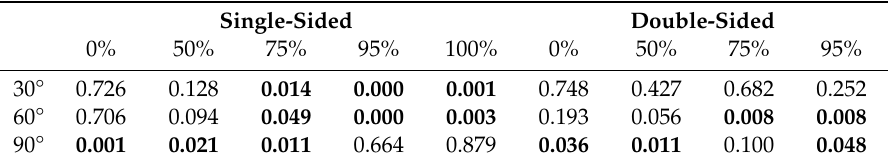
Table A2. p -values for the data presented in Figure 8 (single- and double-sided etched channels with tape on both sides), generated using a two-tailed, unequal variance t-test comparing the 30 ◦ , 60 ◦ , and 90 ◦ conditions to the 0 ◦ (vertical wicking). Values below 0.05 are in bold text.